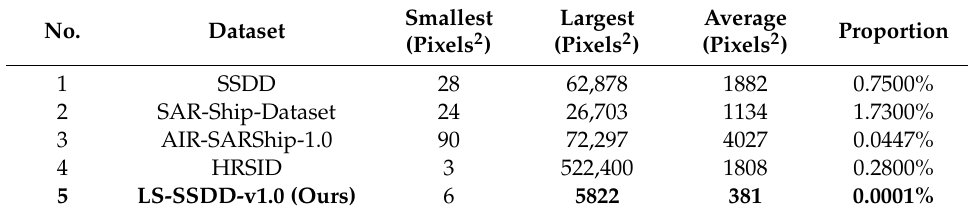
Table 4. Ship pixel size. “Pixels 2 ” refers to the area of ship rectangle box. “Proportion” refers to the proportion of ship pixels occupying the whole image when using average pixels 2 to make a